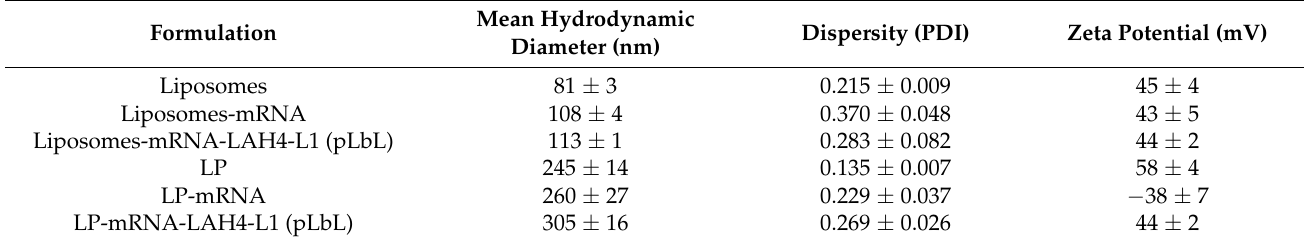
Table 2. Characterization of Fluc mRNA adsorbent formulations prepared through particulate layer-by-layer (pLbL) strategy using either liposomes or LP as carriers (ratio mRNA/LAH4-L1 = 1/20 w / w ). Results are represented as mean ± SD of different batches ( n =